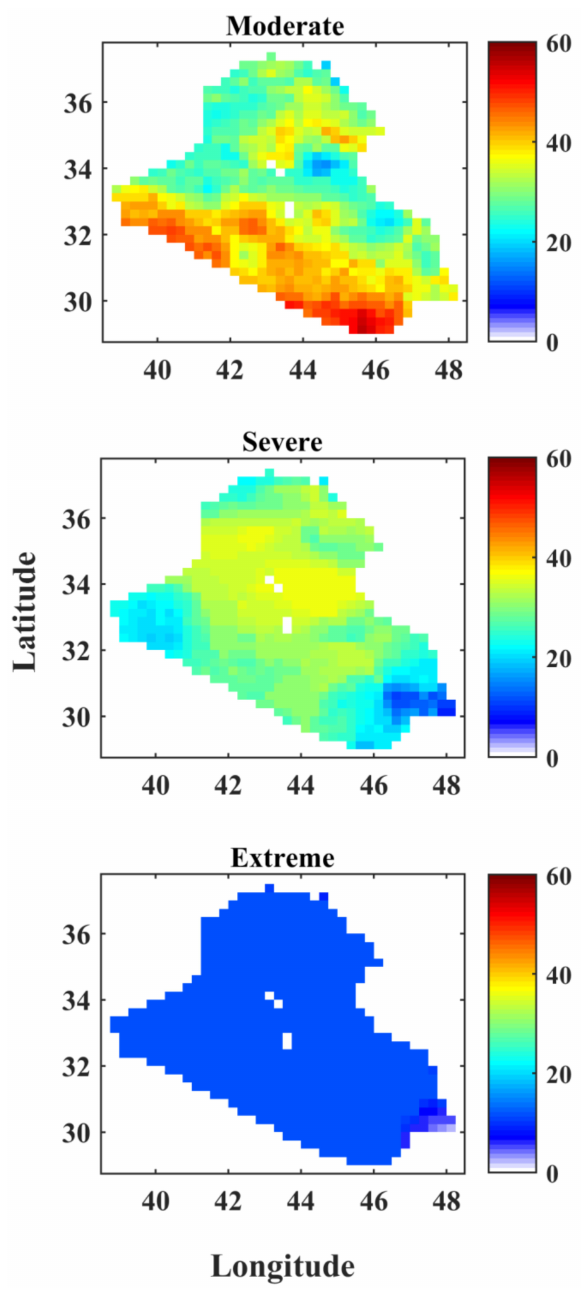
Figure 7. Total duration of drought (in months) for the period of 1998–2009 for each drought type: moderate, severe and